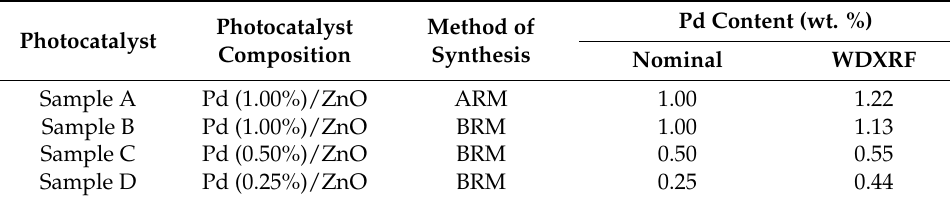
Table 1. Pd content determined by wavelength dispersive X-ray